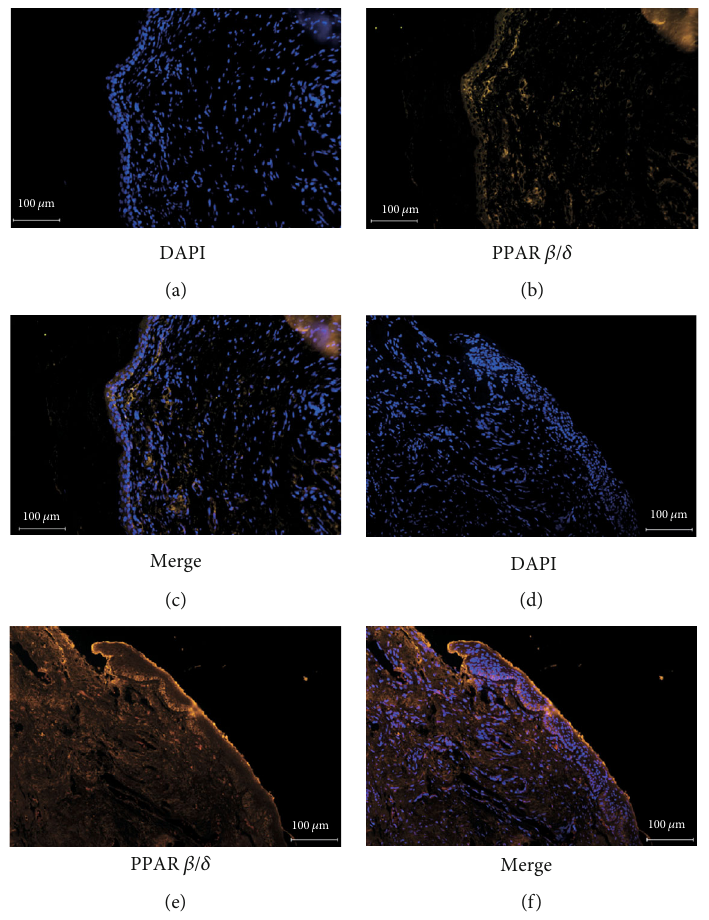
Figure 1: Immunohistochemical staining for proliferator-activated receptor β / δ . PPAR β / δ is scantily expressed in external auditory canal skin (a – c). PPAR β / δ is expressed in the cells mainly in the parabasal and basal layers of cholesteatoma epithelium (d – f). The intensity of its expression is decreased in the granular and prickle cell layers (magni fi cation, ×